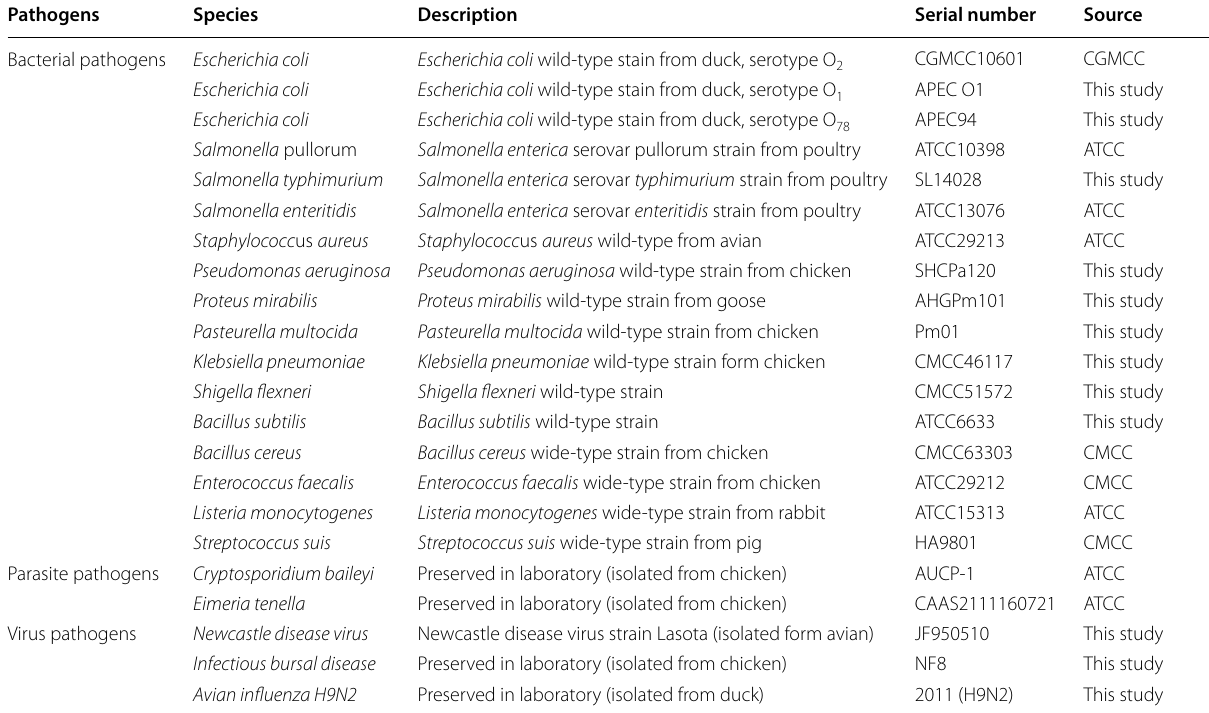
CGMCC China General Microbiological Culture Collection Center, ATCC American Type Culture Collection, CMCC China Medical Microbial Culture Collection Management Center